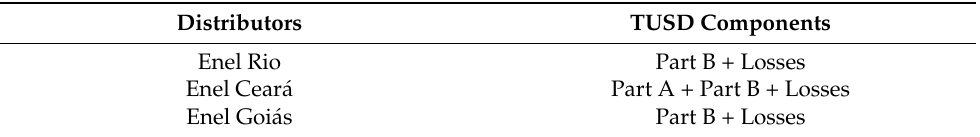
Table 4. TUSD components for calculating the impact of MMDG on the concessionaire, based on data from ANEEL [7]. Distributors TUSD Components Enel